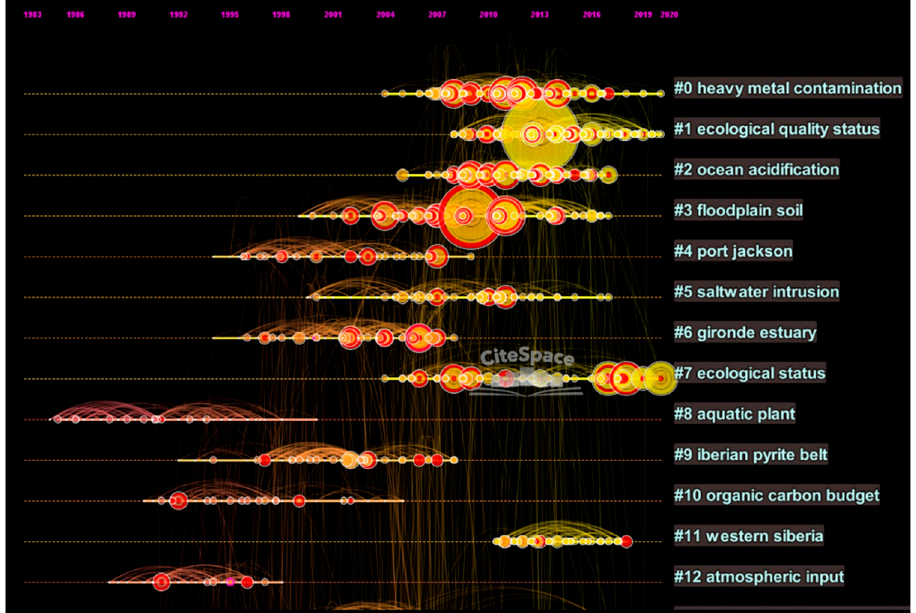
Figure 8. The most cited clusters in studies related to the impacts of climate change on heavy metal contamination in coastal areas, based on the Web of Science Core Collection database (1979–2021).